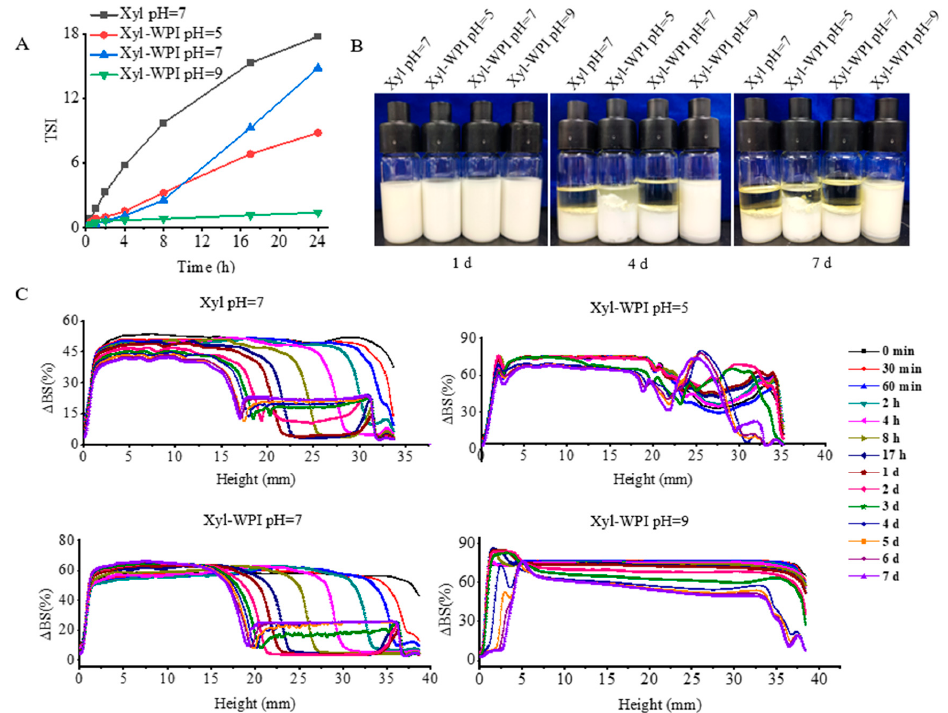
Figure 2. Global stability of different W/O emulsions during 7 days of storage at 25 °C. ( A ) TSI values of emulsions within 24 h. ( B ) The appearance of emulsions kept at day 0, 4, and 7. ( C ) Backscattering profiles ( Δ BS) of emulsions within 7 days. Xyl W/O: Emulsion stabilized by PGPR; Xyl-WPI W/O: Emulsion stabilized by PGPR and WPI; pH refers to the pH value of internal aqueous phase.